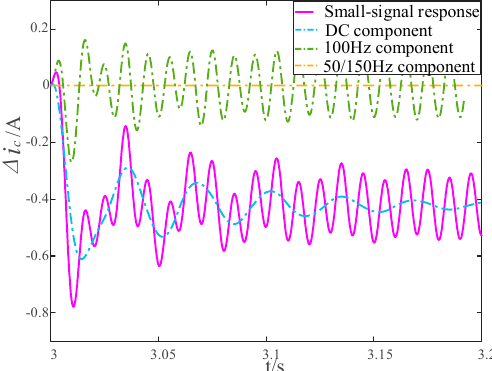
Figure 8. Step response comparison of i c ( t ) with open-loop control mode. ( a ) Zoom-out view of i c ( t ). ( b ) Zoom-in view of i c ( t ).